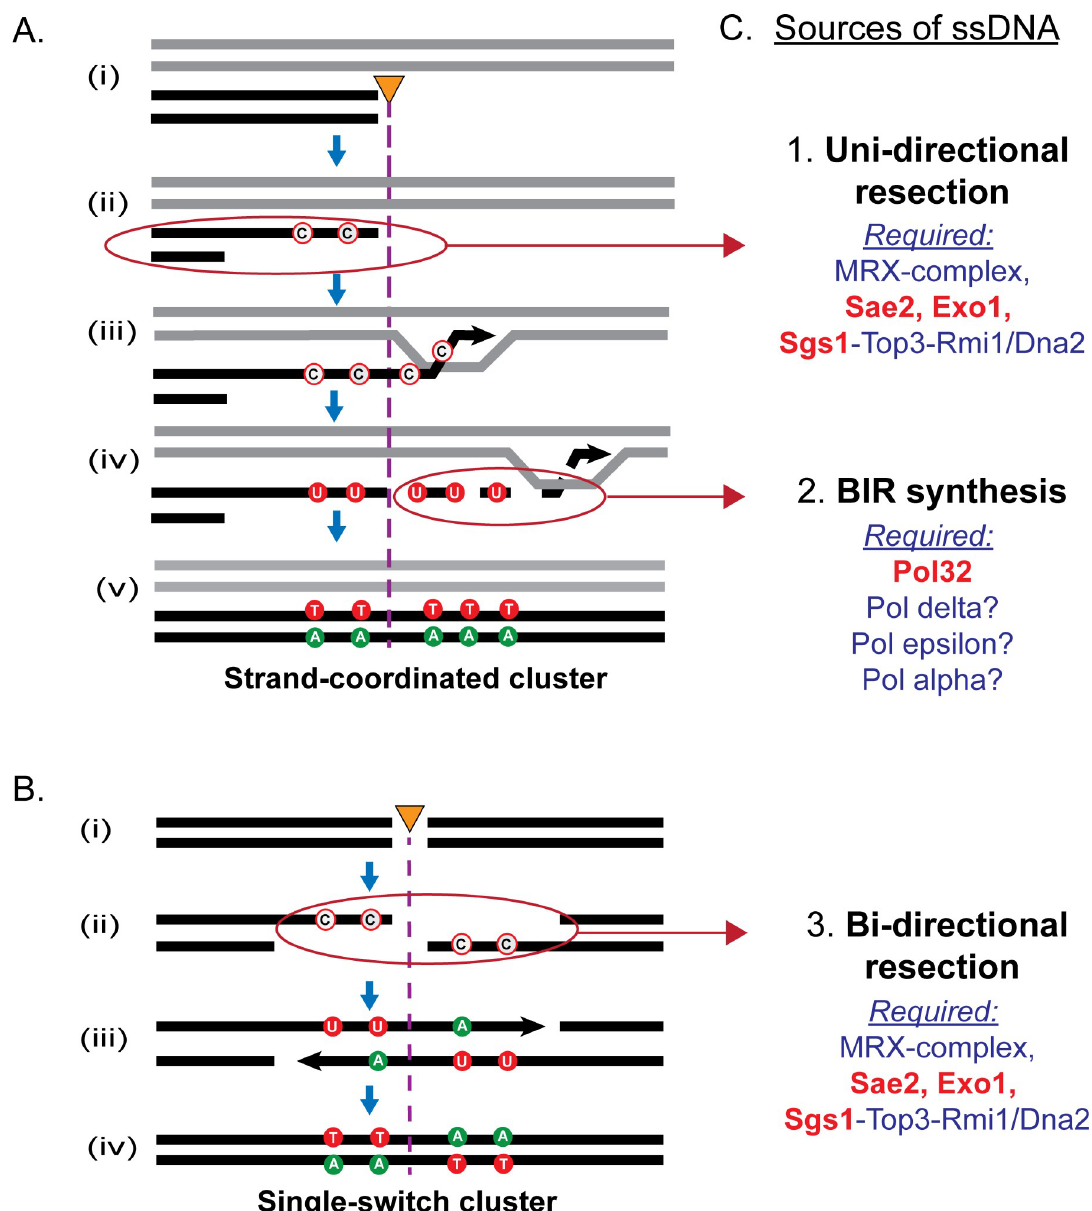
Fig 1. DSB repair pathways generating ssDNA vulnerable to hypermutation by APOBEC cytosine deaminase. The figure includes the following symbols designating nucleotides, mutations, and DNA strands: “unfilled red circles,” nonmutated cytosines; “green-filled circles,” contains a base replacing mutated guanines; “red-filled circles,” contains a base replacing mutated cytosines; “black arrowheads,” 3 0 end of DNA strand extended by DNA polymerase; “orange triangle with purple dotted line,” position of DSB; “C,” cytosine; “A,” adenine; “U,” uracil; “T,” thymine. On both panels, C to U changes are due to APOBEC cytosine deamination in the absence of uracil DNA glycosylase. (A) ssDNA formed during BIR repairing a one-ended DNA break. (i) Black lines show one-ended DNA break, and gray lines show a homologous template for repair. (ii) ssDNA generated from 5 0 to 3 0 end resection, resulting in a 3 0 overhang. (iii) Invasion into a homologous template that initiates DNA synthesis. (iv) Progression of DNA synthesis generating a long ssDNA tail behind the migrating BIR replication bubble. Cytosines in ssDNA convert to uracil after deamination by APOBEC. (v) Completed repair of the DNA break by asynchronous lagging strand synthesis restoring DNA to ds form. (Not illustrated is a resolution of joint molecules.) C-coordinated clustered mutations result following one round of cellular replication (not illustrated) in which adenines were inserted opposite uracils, resulting in C:G to T:A mutations. If BIR initiated repair from the opposite side of a DNA break, G-coordinated clusters in the top strand would result from cytosine deamination in ssDNA generated on the bottom DNA strand (not illustrated). (B) ssDNA formed from bidirectional resection at a DSB. (i) DSB. (ii) 5 0 to 3 0 end resection generating ssDNA on both sides of the DNA break. (iii) Cytosines in ssDNA on the top (left) and bottom (right) DNA strands are converted to uracil by APOBEC